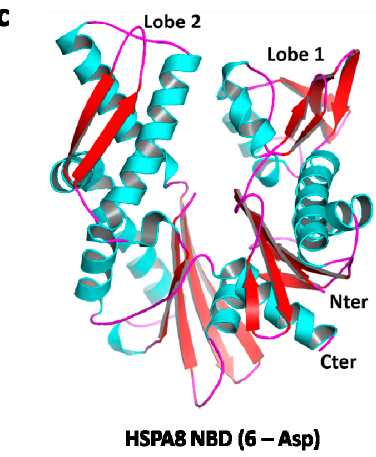
Figure 2. HSPA8 structure. ( a ) HSPA8 encompasses three main structural domains, namely the nucleotide-binding domain (NBD), which binds and hydrolyzes ATP, as well as a short hinge domain assuring flexibility between the two main domains, and thirdly, the substrate-binding domain (SBD) that contains two subdomains, namely a 15-kDa β -sandwich that binds peptide substrates, and a 10-kDa R-helix acting as a lid over the substrate binding site, and which is therefore central for chaperone/co-chaperone binding. Eukaryotic cytosolic HSPA8 contain a G/P-rich C-terminal region harboring an EEVD-motif involved in the binding of co-chaperones and other HSPs. ( b ) Structure of HSPA8 under two distinct states, namely ATP [PDB code 5AQM) and ADP [PDB code 4H5T) states with nucleotide exchange factors (NEFs) and J proteins, respectively [44,45]. ( c ) Overall structure of HSPA8 NBD (6—Asp). The NBD is divided in two lobes. The α -helices are depicted in blue, the β -sheets in red and the loops in purple (Ruff M. and Muller S., unpublished). HSPA8 binds to small hydrophobic stretches of either nascent or partially-unfolded proteins in an ADP/ATP-dependent manner. HSPA8 first binds client proteins in a low-affinity, fast exchange